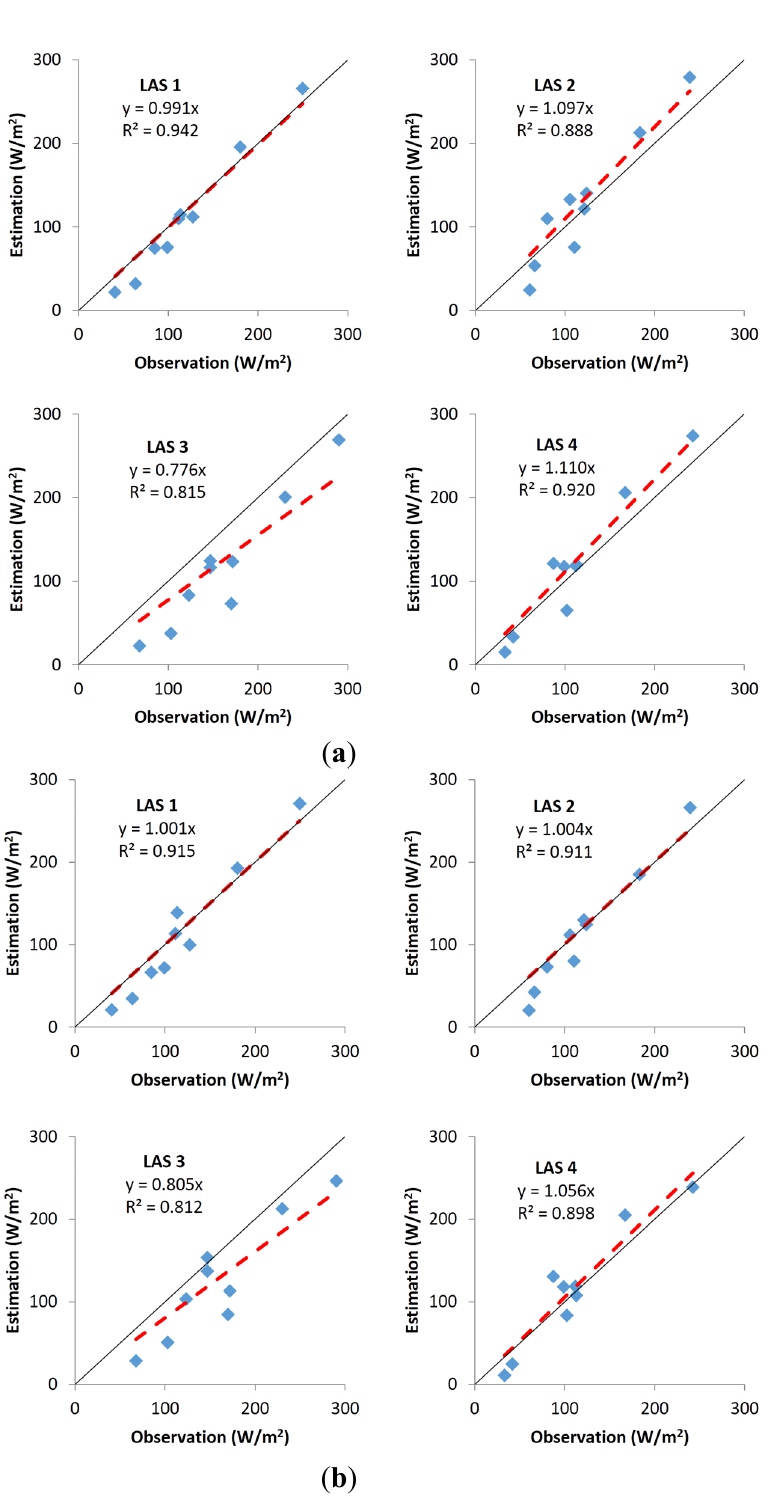
Figure 3. Comparison of estimations and observations for LAS H. ( a ) Estimated by regression; ( b ) estimated by WATA regression